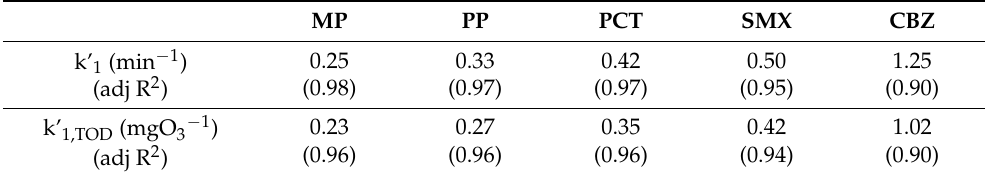
Table 3. Pseudo-first order kinetic rate constants of ozone-treated contaminants as a function of time (k’ 1 ) and as a function of TOD (k’ 1,TOD ), with the corresponding adjusted coefficients of determination (adj R 2 ). MP PP PCT SMX CBZ k’ 1 (min − 1 )